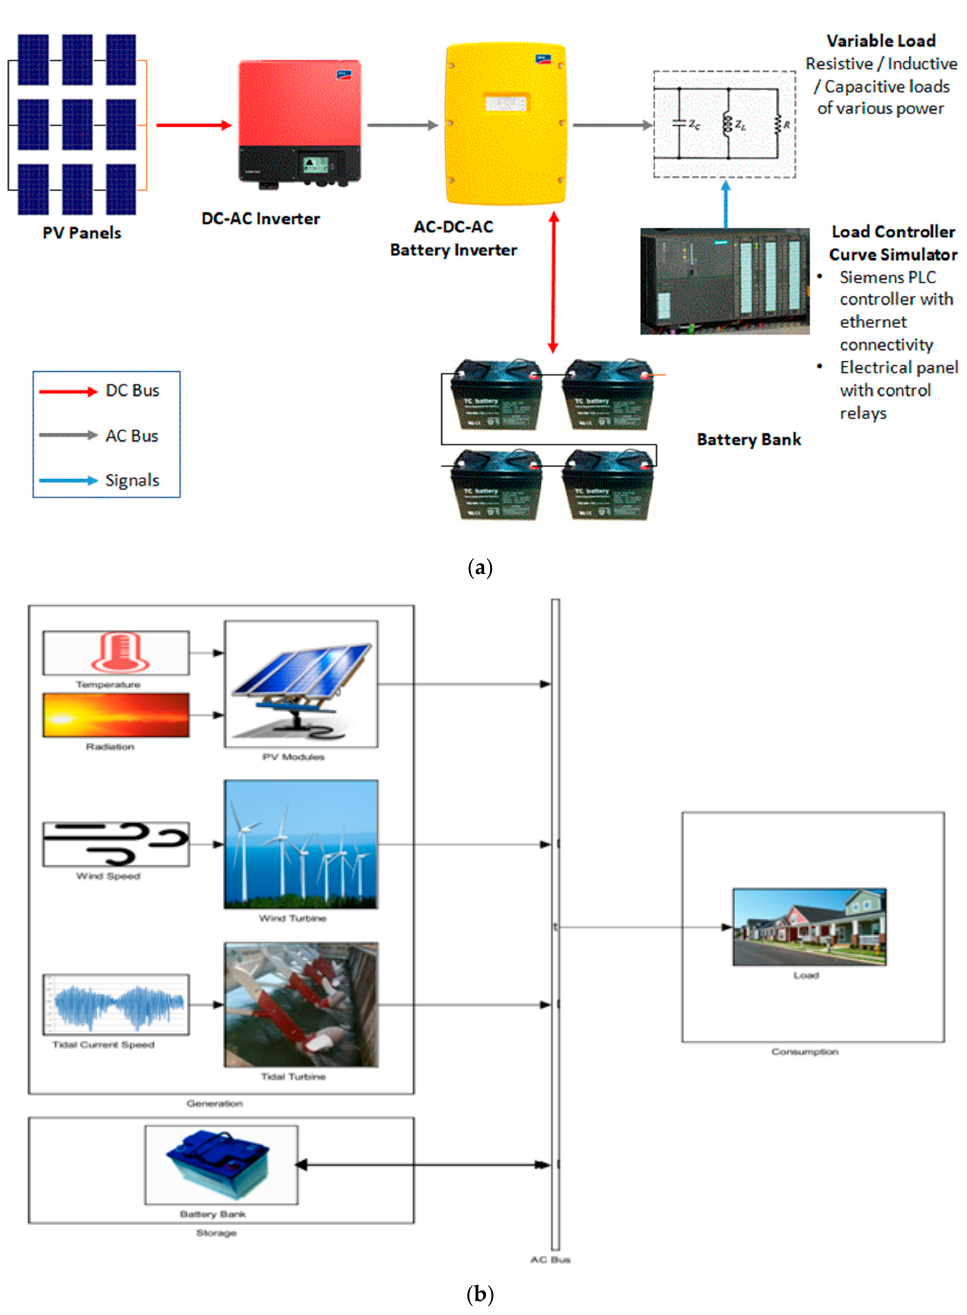
Figure 1. The block diagrams of the ( a ) actual Energy Systems Laboratory microgrid ( b ) modeled microgrid.